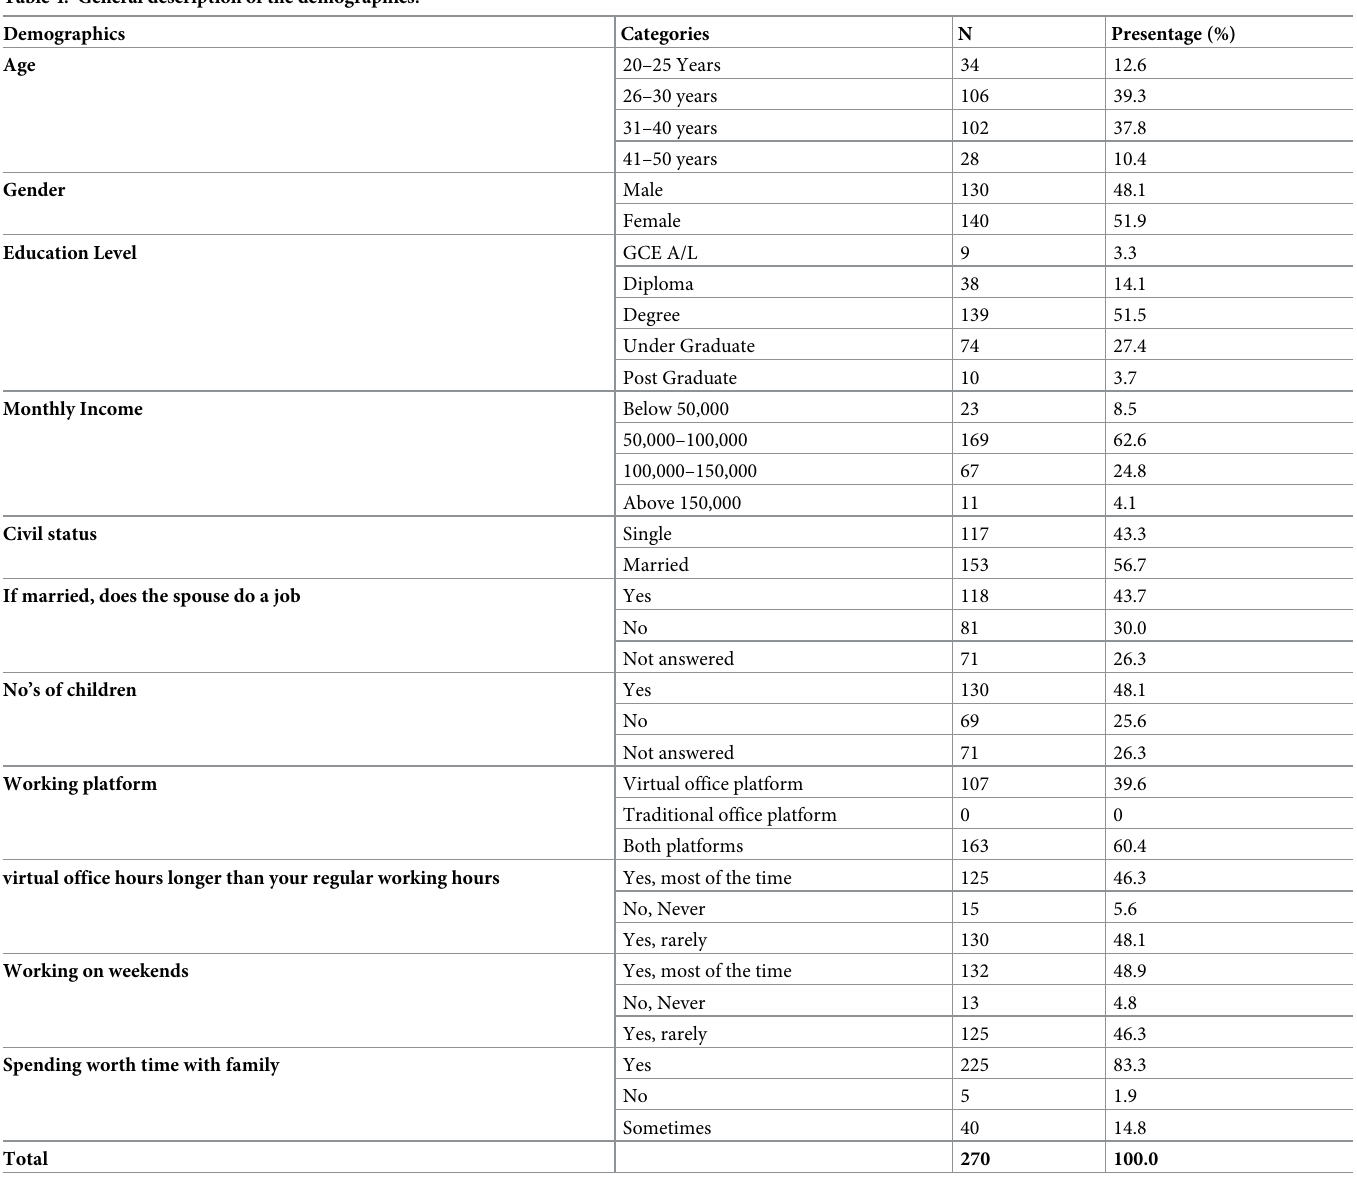
Table 4. General description of the